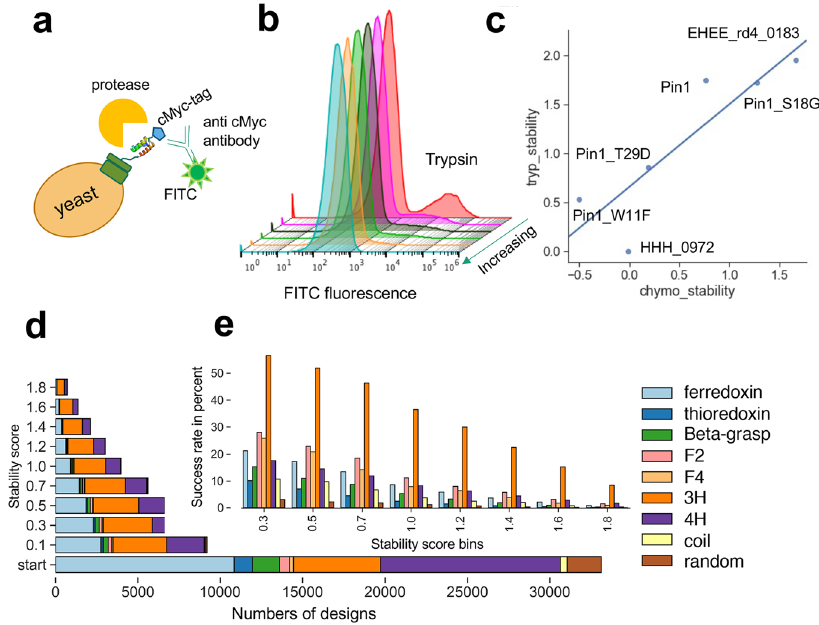
Fig.2|Characterizationofdesignedsmallproteinsusingaprotease-basedhigh throughput screen on the yeast surface and biochemical analysis of individu- ally expressed proteins. a Cartoon scheme of yeast surface display experiment. Unfolded proteins are cleaved and, thereby, will not be fl uorescently labeled. b FITC fl uorescenceafterincubationofyeastcellsdisplayingthedesignedproteins as a pool with increasing concentration of trypsin; cells were labeled with a c-Myc